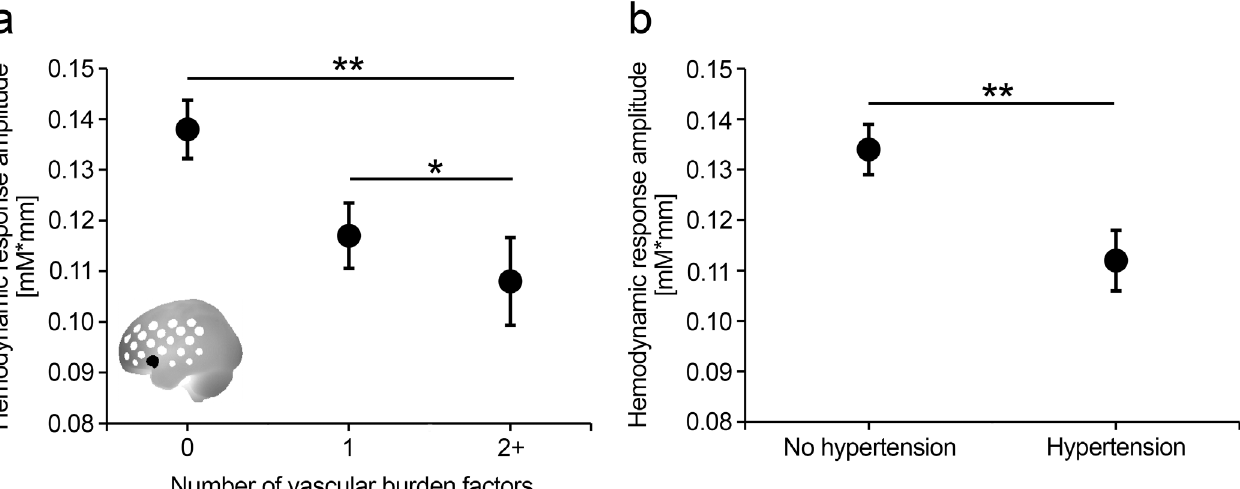
Fig 3. Mean hemodynamic response amplitudes (left channel 3, indicated in black, left inferior frontal junction) with standard errors of the mean in the peak activation region during phonological fluency. Mean amplitudes were adjusted for the covariates age, sex, education and performance of mean amplitudes. Values are shown for a) individuals without, with one, or with two or more vascular burden factors, and b) for individuals without and with hypertension.